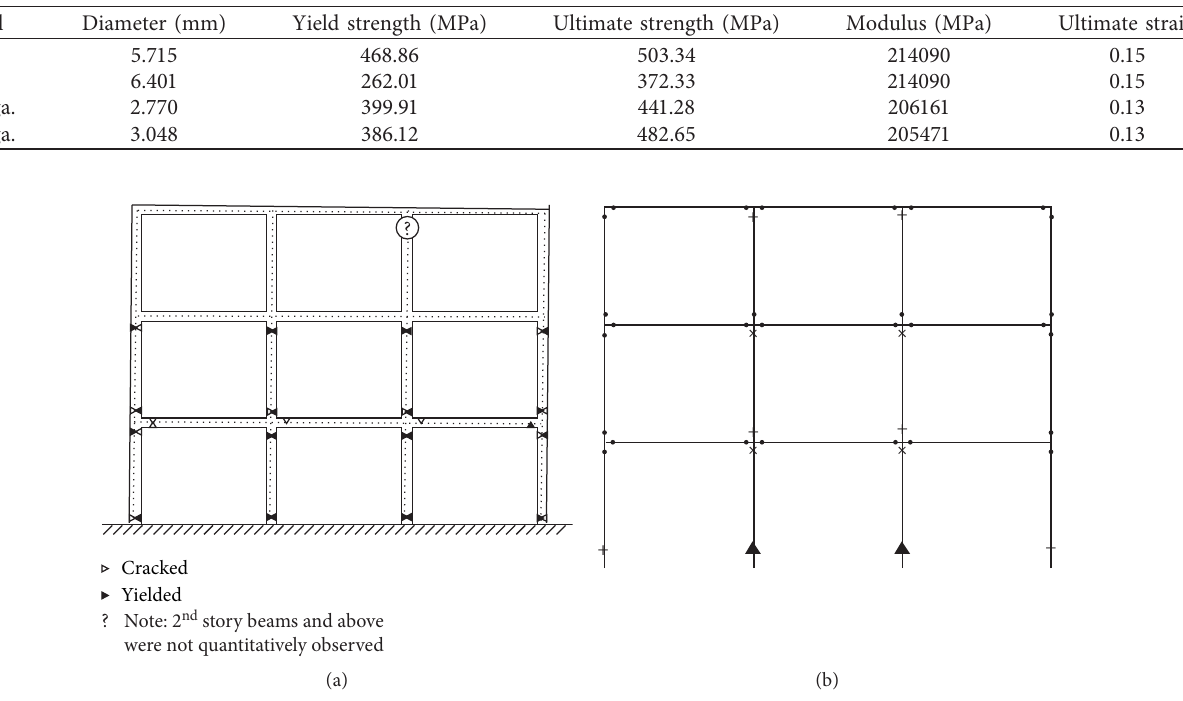
Figure 12: Comparison of damage modes. (a) Experiment [76] and (b) analysis.